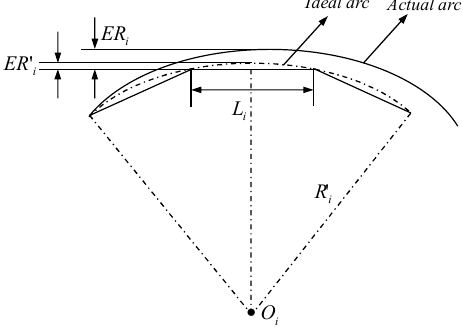
Figure 17. Schematic diagram illustration of cutting linearization error.